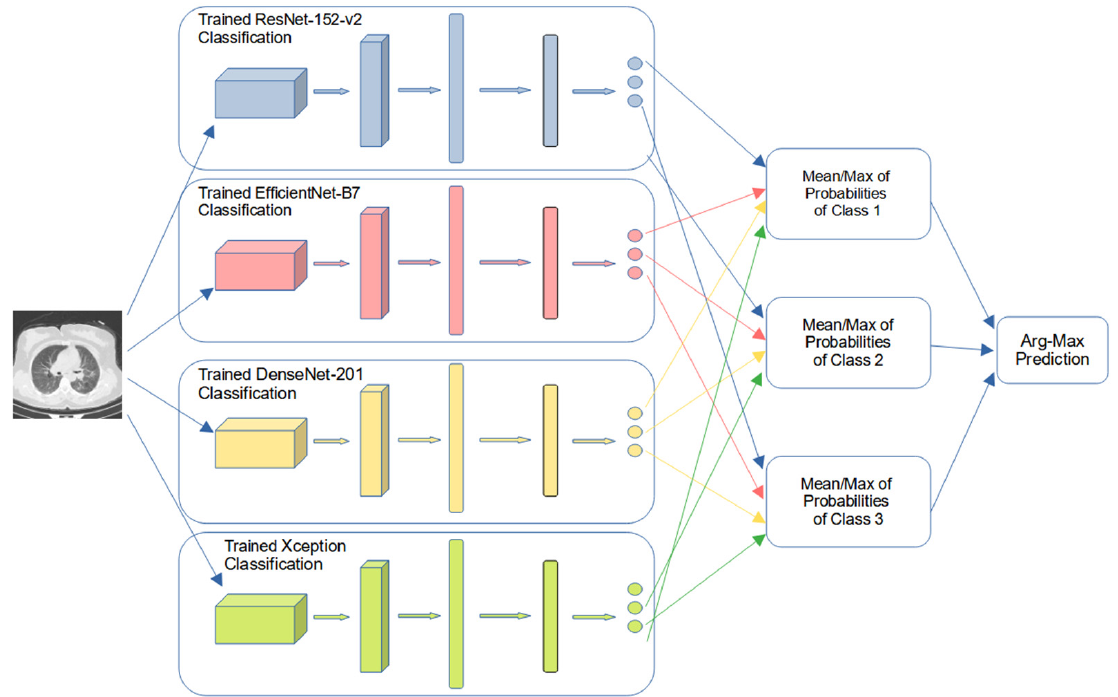
Figure 8. Deep Voting Ensemble Model.